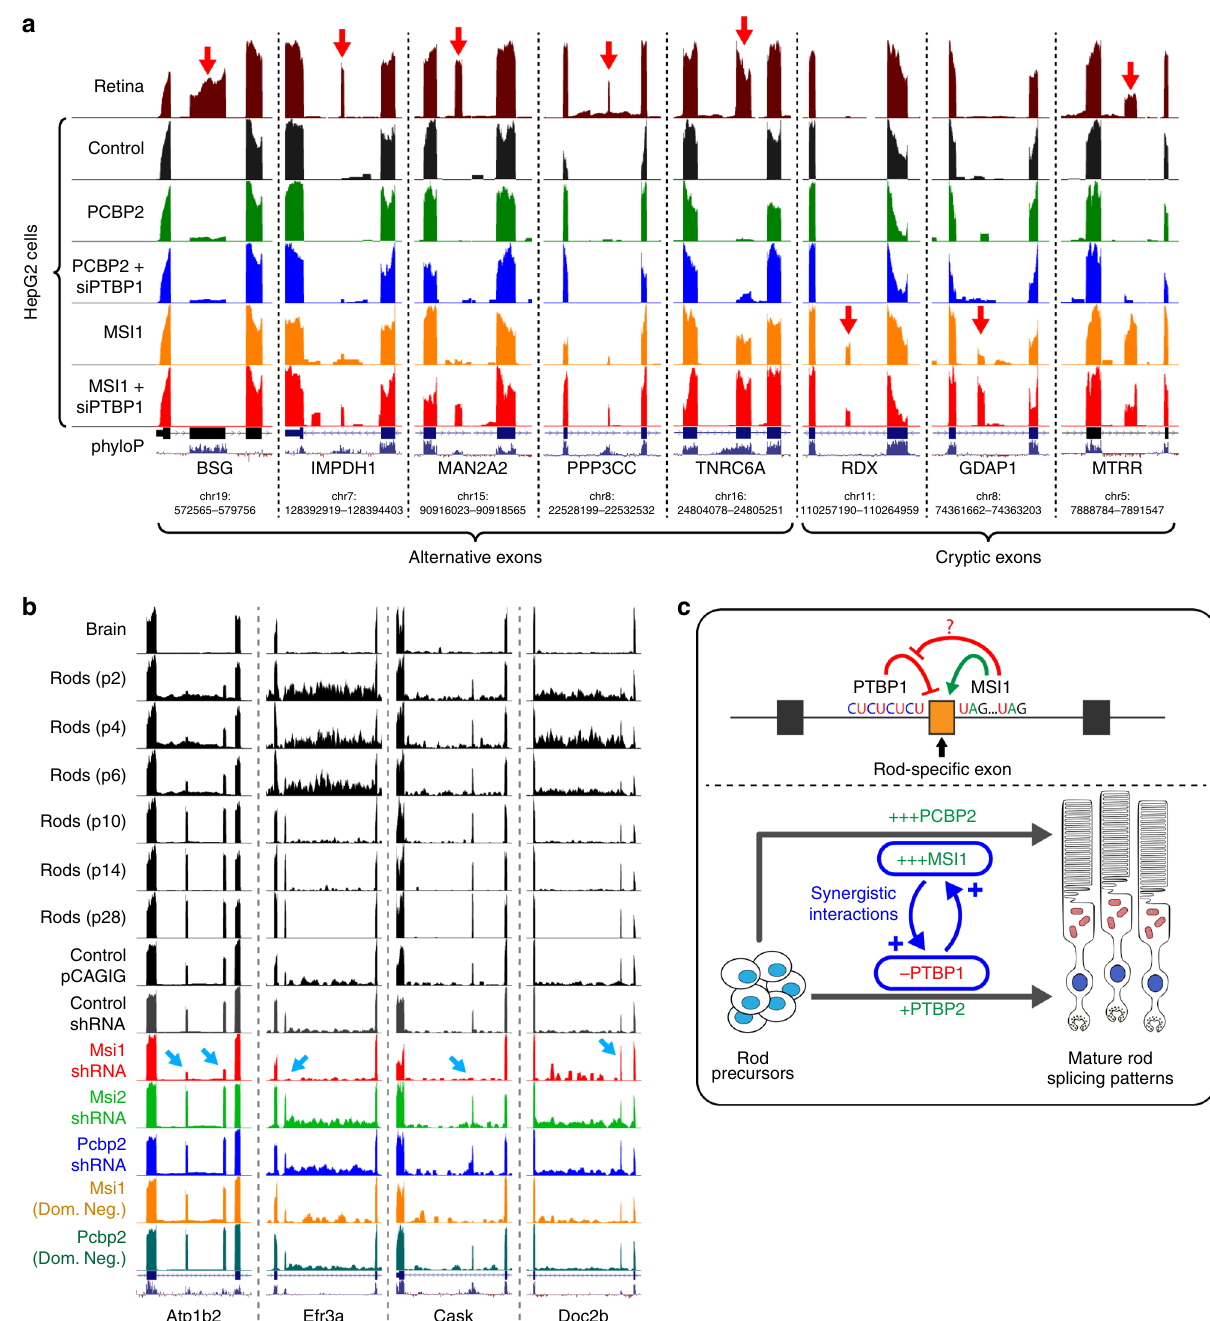
Fig. 5 Visualization and pathway analysis of rod-speci fi c exons and electroporation of mouse retina. a UCSC visualization of rod-speci fi c exons, both alternative ( BSG , IMPDH1 , MAN2A2 , PPP3CC , TNRC6A ) and cryptic ( RDX , GDAP1 , MTRR ). Overexpression of PCBP2 activates the rod-speci fi c exon in BSG , independent of PTBP1 knockdown. By contrast, MSI1 overexpression in combination with PTBP1 knockdown activates both rod-speci fi c exons ( IMPDH1 , MAN2A2 , PPP3CC ) and pan-neuronal exons ( TNRC6A ). High levels of MSI1 overexpression can also activate cryptic exons ( RDX , GDAP1 ) that are not found elsewhere in the body. However, some of the cryptic exons activated by MSI1 overexpression are not cryptic and can be found in photoreceptors ( MTRR ). b Electroporation of Msi1 shRNA in mouse retina abolishes nearly all rod-speci fi c splicing ( Atp1b2 , Efr3a , Cask ). However, some rod-speci fi c exons ( Doc2b ) remain unaffected (Supplementary Fig. 11). c Model for the regulation of photoreceptor-speci fi c splicing. Increased expression of MSI1 and downregulation of PTBP1 act synergistically to activate rod-speci fi c exons, while increased PCBP2 expression can activate the rod-speci fi c exon in BSG